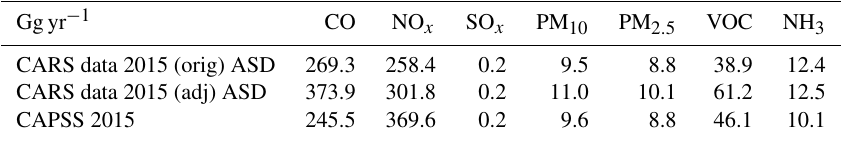
Table G1. The annual emission rate between original road type ASD, adjusted road type ASD, and CAPSS result for